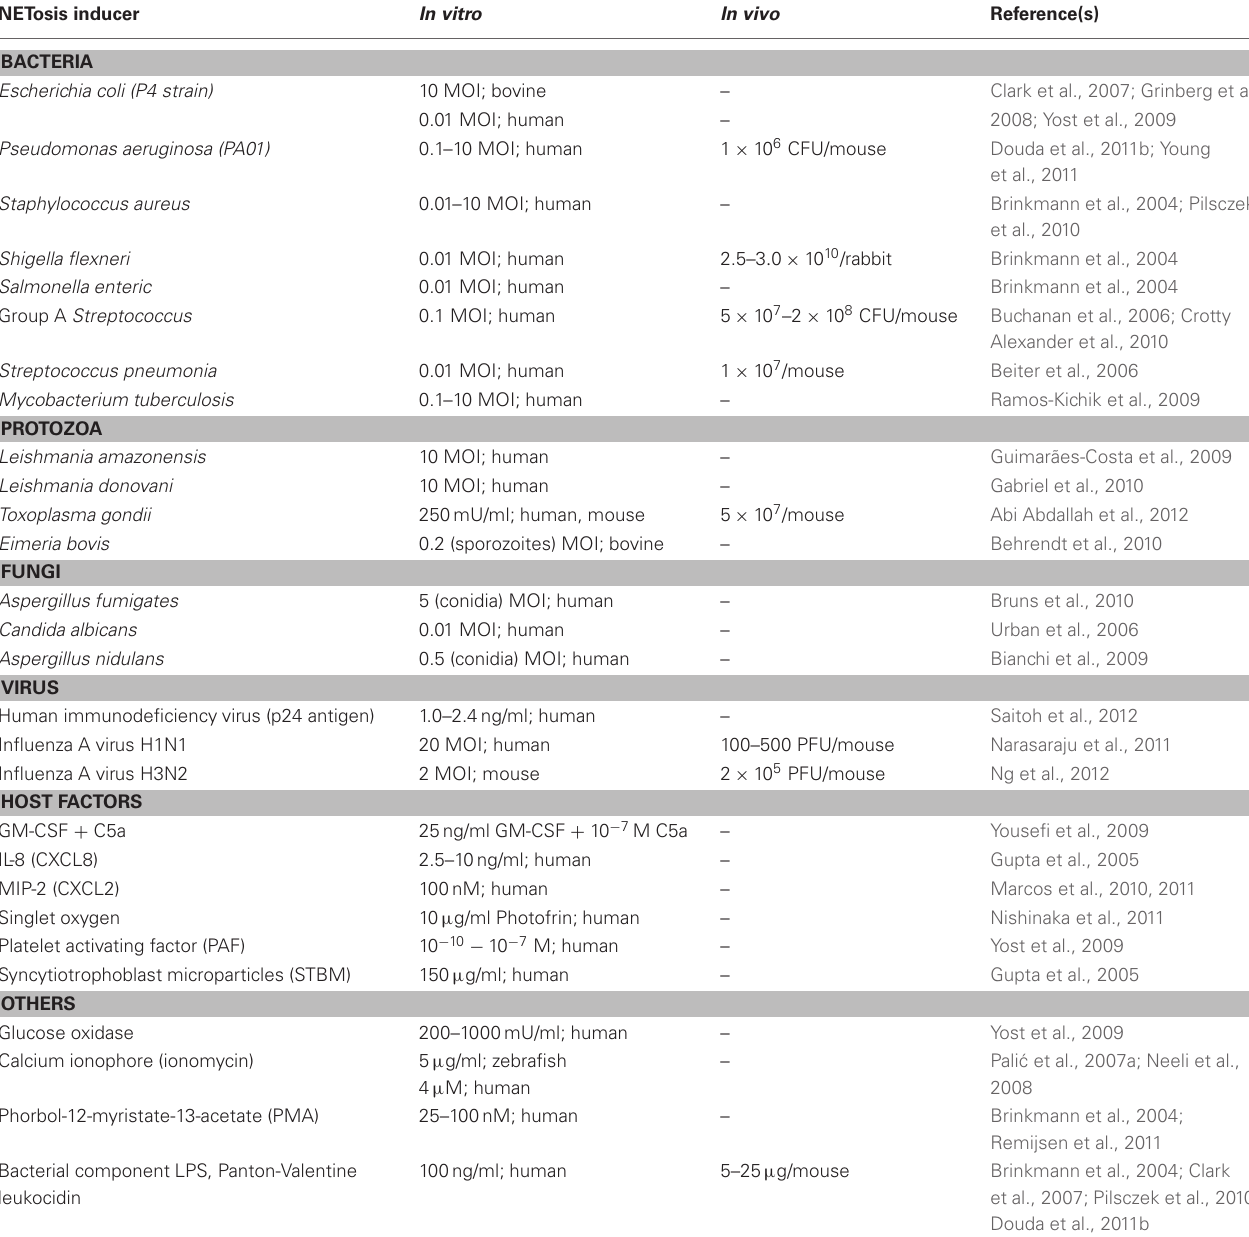
Table 1 | NETosis-inducing